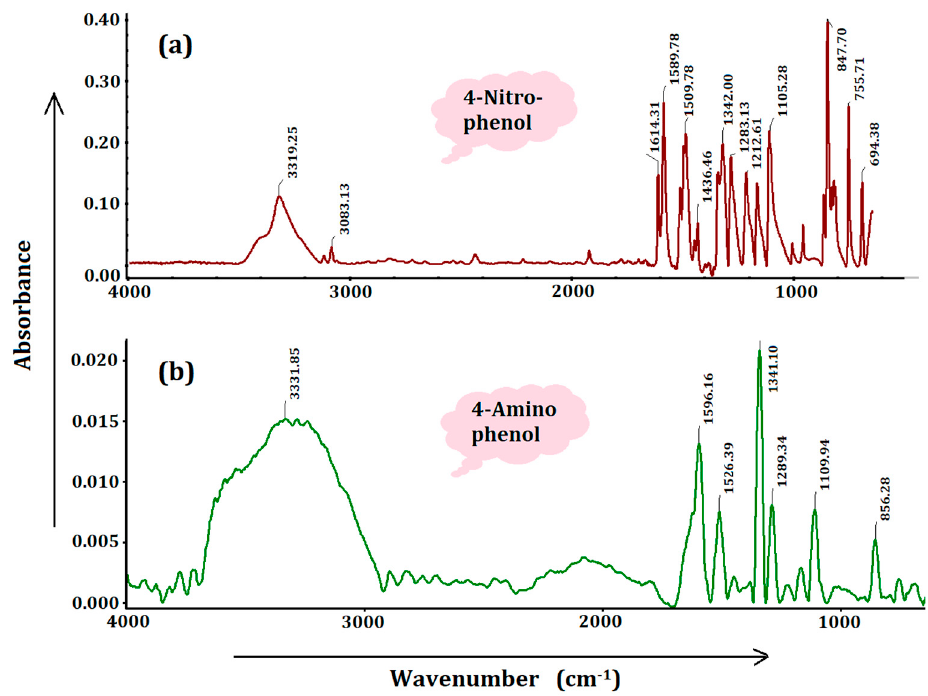
Figure 9. DRS-FTIR spectra of ( a ) 4-Nitrophenol and ( b ) 4-Aminophenol.